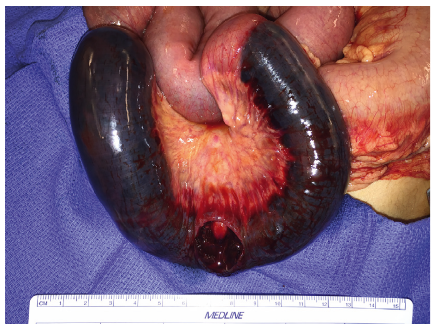
Figure 4: Intramural